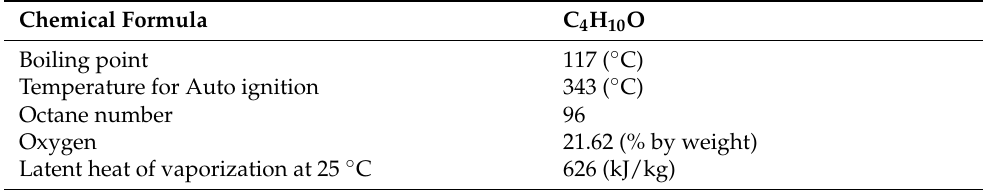
Table 2. Allied characteristics of the n-butanol [18,19].